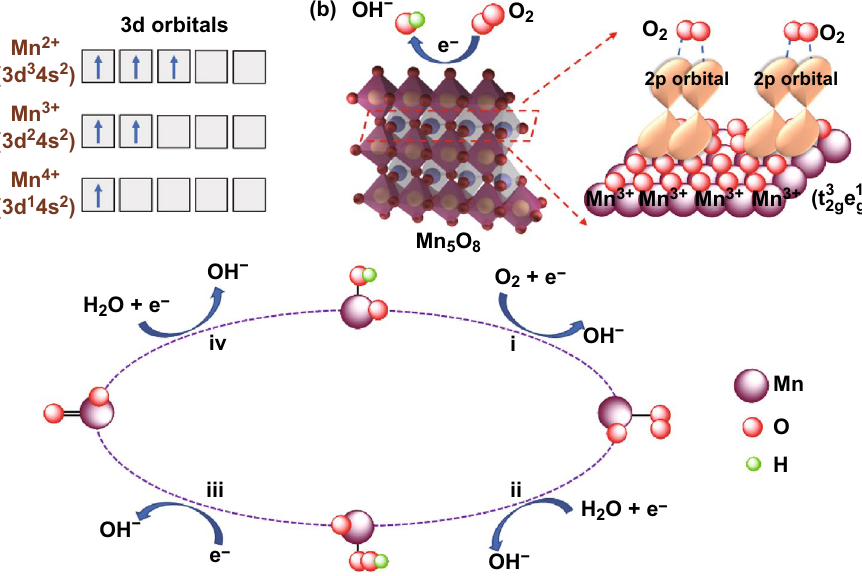
Fig. 6 a Occupied states of 3 d orbitals for Mn 2+ , Mn 3+ and Mn 4+ . b Lattice structure of Mn 5 O 8 (yellow: Mn 4+ ; blue: Mn 3+ ) and the ball-stick model of the O 2 molecule adsorptions on the surface. c Possible four-electron reaction mechanism for MnO x in ORR